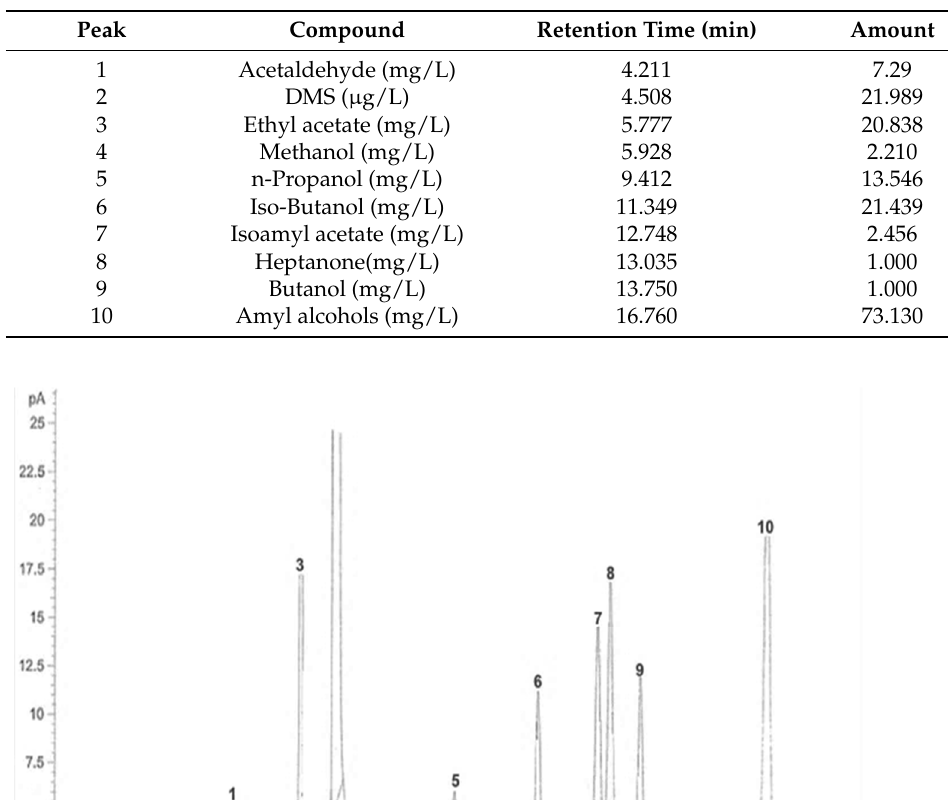
Table 6. Aromatic compounds of a final product of beer under classical fermentation.